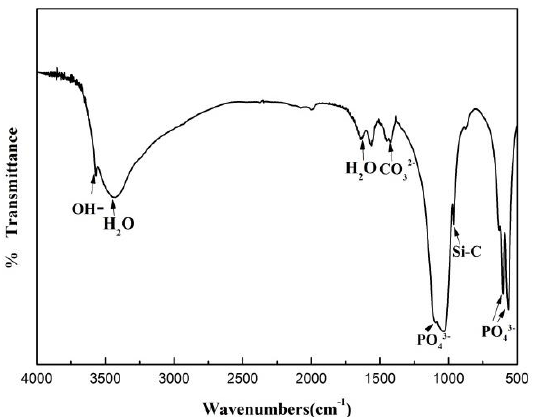
Figure 4. The FTIR spectra of the SiC-hydroxyapatite (200 nm, 1 g/L) coatings. The bonding strengths between the SiC-hydroxyapatite coatings and the C/C com- posite’s matrix were determined by scratch tests. The analysis of the chemical bonding strengths between the coatings and the C/C composites matrix showed that the bonding strength of the hydroxyapatite coatings significantly increased when SiC was incorpo- rated. Additionally, the overall bonding strength increased as the SiC particle increased (see Figure 5). Thus, SiC-hydroxyapatite coatings containing 200 nm SiC particles exhib- ited the strongest bond between the hydroxyapatite coatings and the matrix. The bond- ing strengths for the SiC-hydroxyapatite coatings containing 50 and 100 nm SiC particles were almost the same. The pristine hydroxyapatite coating was loose and cracked (see Figure 3a) which explained its poor mechanical and binding strength. However, the SiC-hydroxyapatite coatings containing 200 nm SiC particles were uniform and dense (see Figure 3d), which explained why their binding strength was the highest of all the coatings. Figure 5. Adhesion strength of SiC-hydroxyapatite coatings at different SiC particle sizes. 3.2. Effect of SiC Content on HA Coating Properties To assess how SiC contents affected the properties of the hydroxyapatite coating deposited on the C/C substrate, we added 200 nm SiC particles at the 0.01, 0.1 and 1 g/L levels. The XRD of these coatings revealed peaks belonging to the C/C composites sub- strate, hydroxyapatite coatings and SiC particles (see Figure 6). As the SiC content in- creased, the intensities of these peaks did not change, indicating that the increased SiC